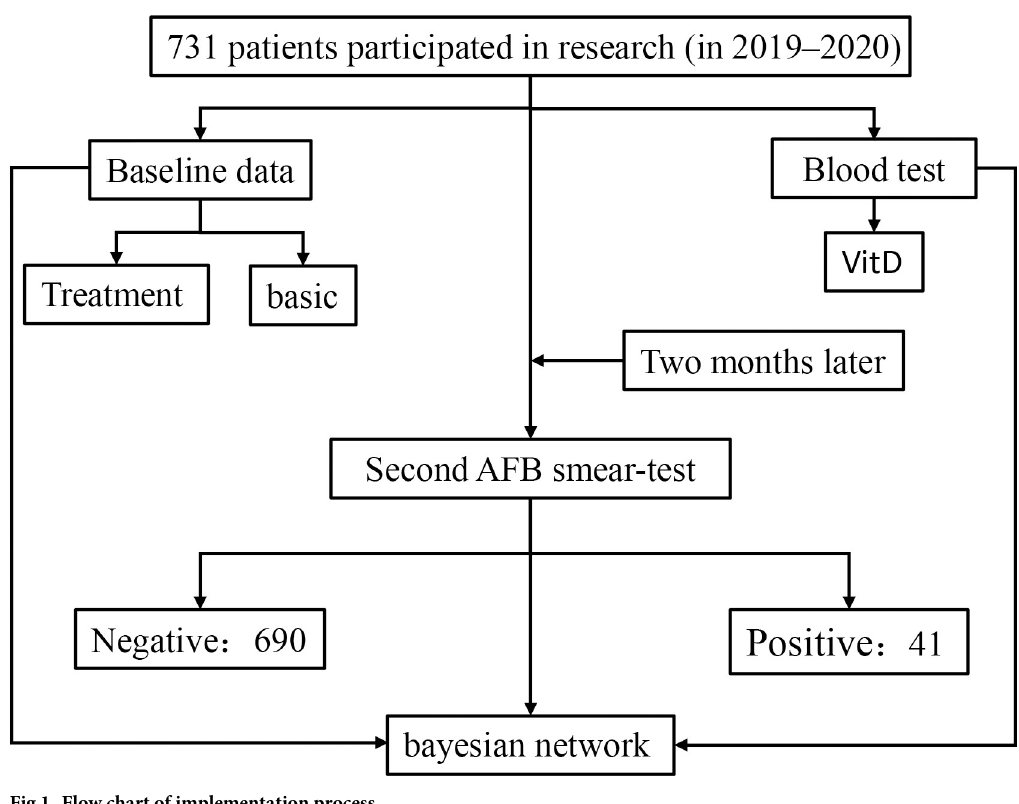
Fig 1. Flow chart of implementation